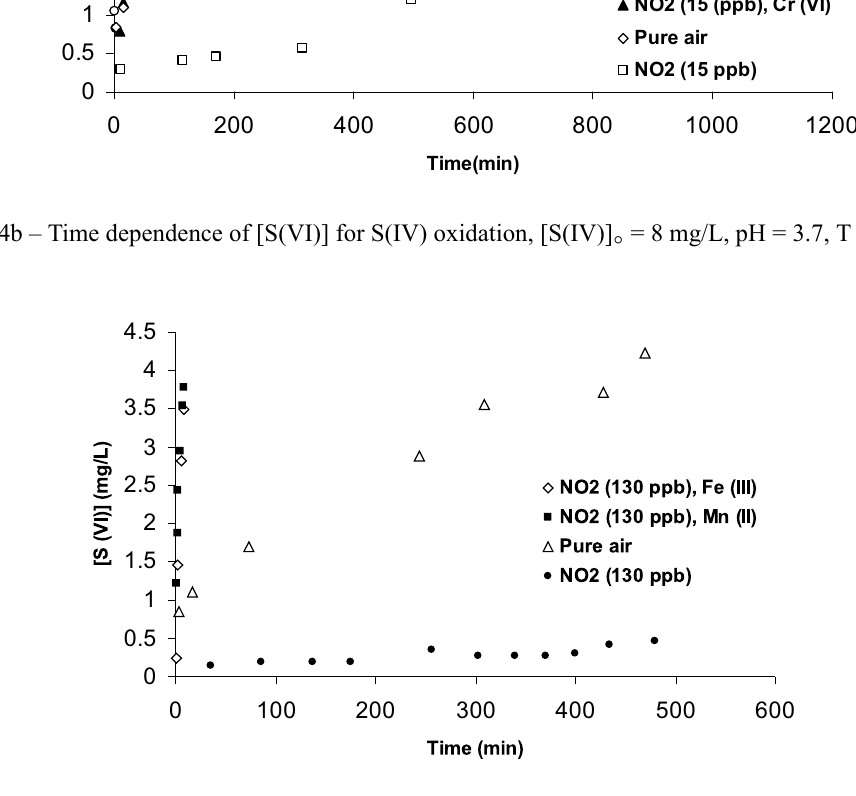
Fig. 5 – Time dependence of [S(VI)] for S(IV) oxidation, [S(IV)] ◦ = 8 mg/L, T = 22 ◦ C, pH = 3.7. At the higher concentration of 130 ppb of NO and an initial concentration of S(IV) of 0.8 2